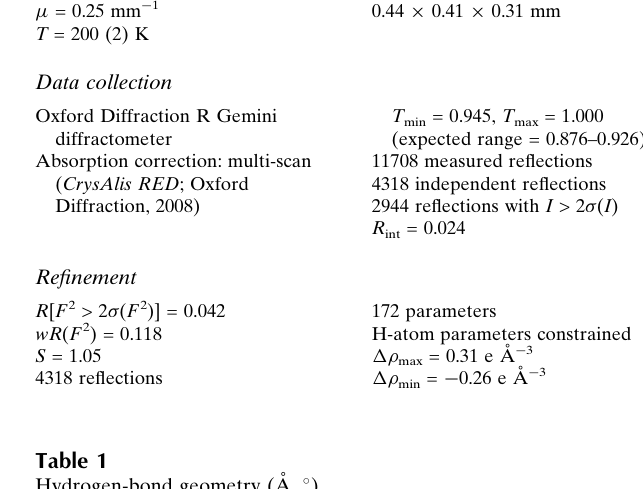
Hydrogen-bond geometry (A˚ , (cid:1)